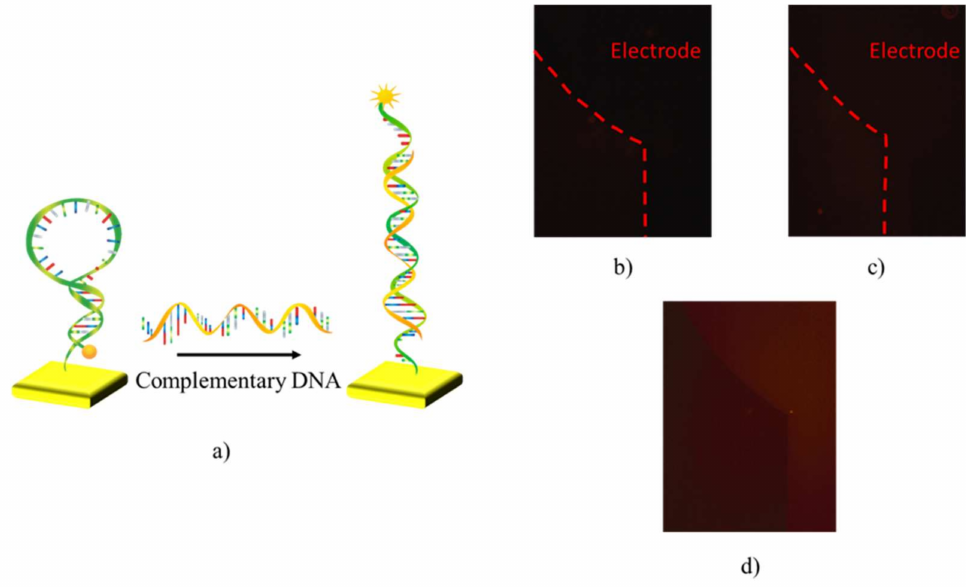
Figure 1. ( a ) Schematic representation of the hairpin probe working principle in the study of its anchoring and functionality. Fluorescence microscopy image of the transistor sensing area before ( b ) and after ( c ) probe immobilization. The fluorescence signal increases after the introduction in solution of fully-complementary ssDNA ( d